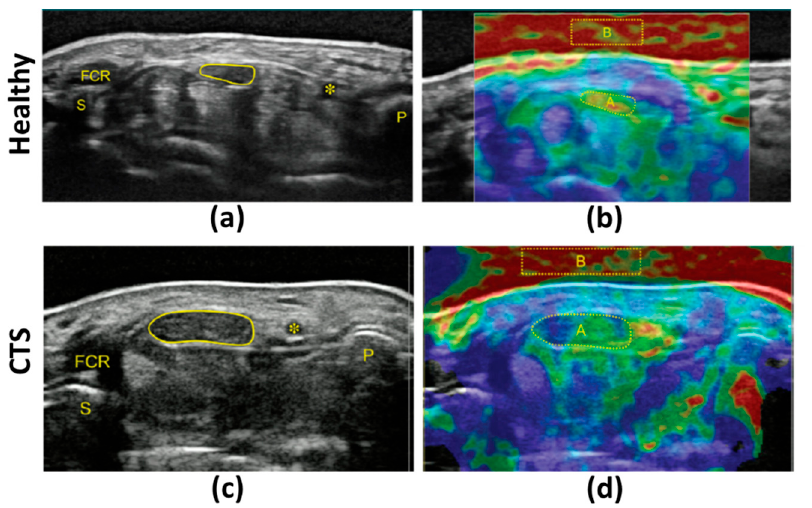
Figure 6. ( a ) B-mode and ( b ) strain images in the transverse plane of the median nerve in a healthy subject (57-year-old female). ( c ) B-mode and ( d ) strain images in the transverse plane of the median nerve in a CTS patient (64-year-old female). Strain ratio (SR) was measured by comparing the strain values in the median nerve (indicated with A in ( b , d )) with an acoustic coupler rubber (ACR) as an external reference (indicated with B in ( b , d )). The median nerve in the CTS patient showed a higher SR (ACR/Median nerve) and CSA. These figures were previously presented by Miyamoto et al. [34]. Reprinting permission is granted by the Radiological Society of North America, which is the copyright holder. Minor modifications were performed for presentation purposes. ∗ = Ulnar artery, FCR = flexor carpi radialis, P = pisiform bone, S = scaphoid